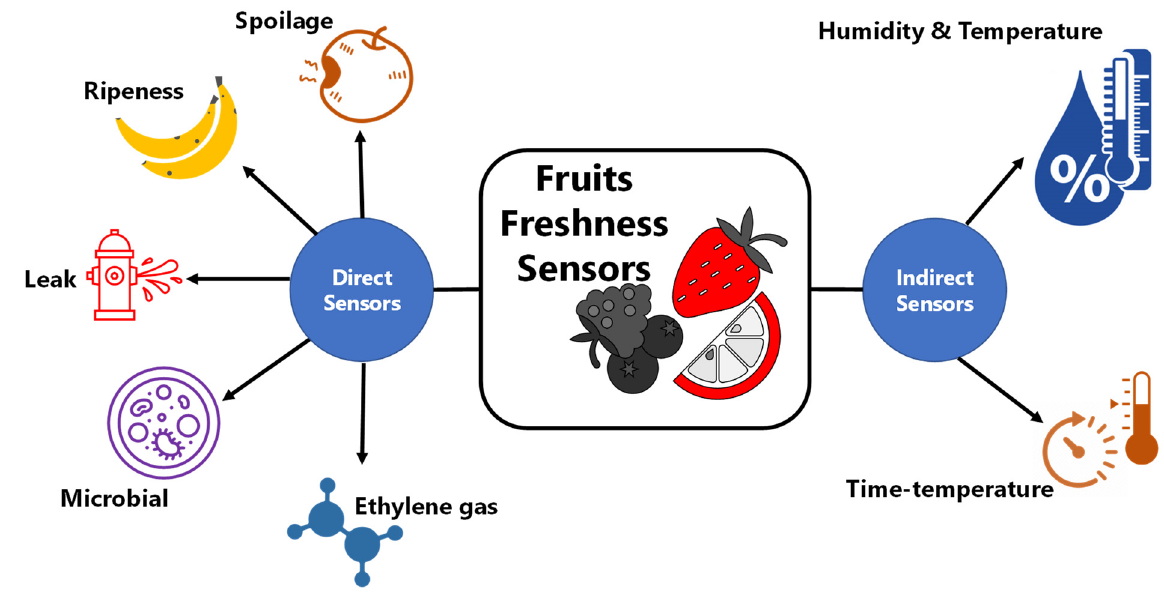
Figure 3. Classifications of sensors for monitoring freshness of fruits.